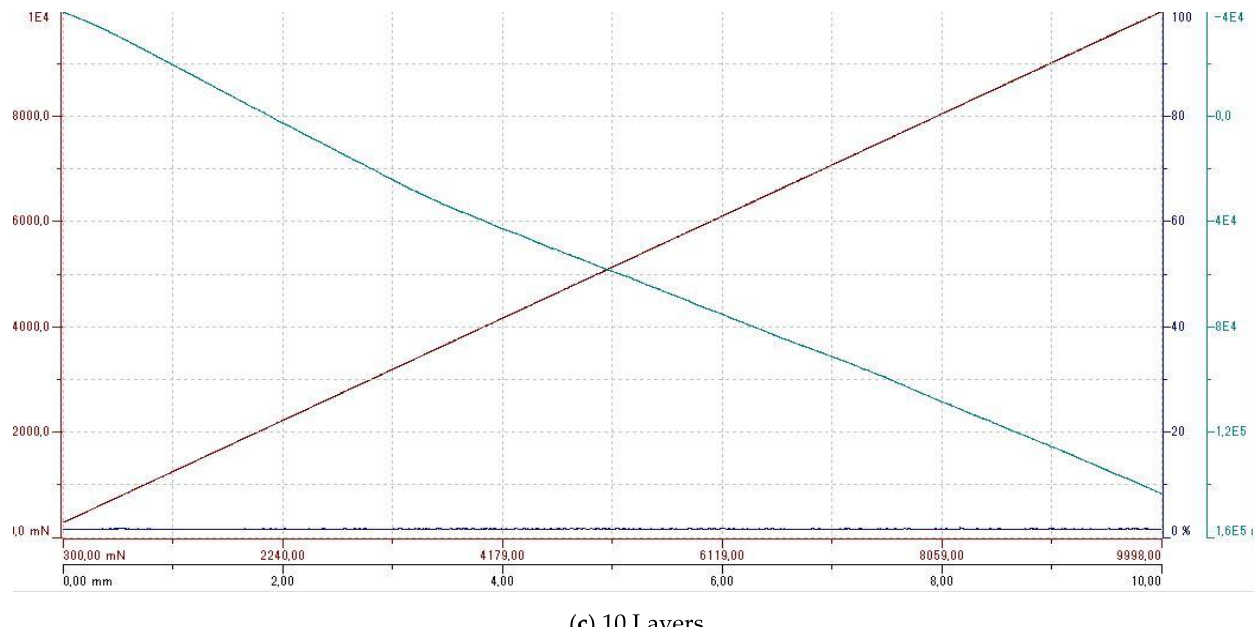
Figure 8. Acoustic emission (AE) graphs obtained when performing the scratch test for the studied samples: ( a ) 6 layers, ( b ) 8 layers, ( c ) 10 layers.